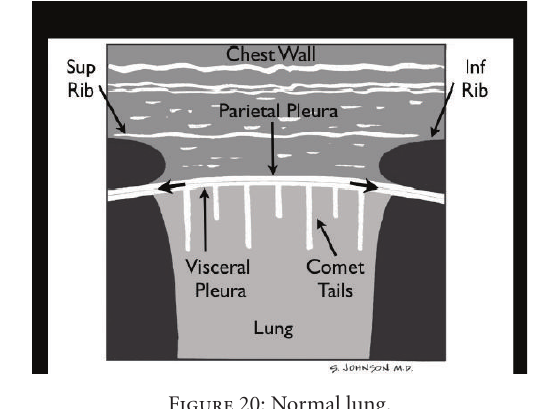
Figure 18: Pleural e ff usion.